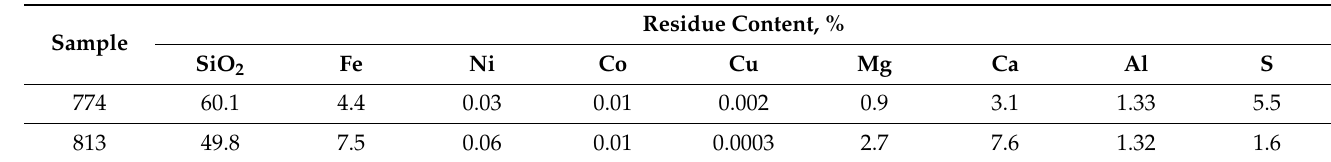
Table 4. The residue composition of slag leaching with hydrochloric acid (Sample 813). Conditions: